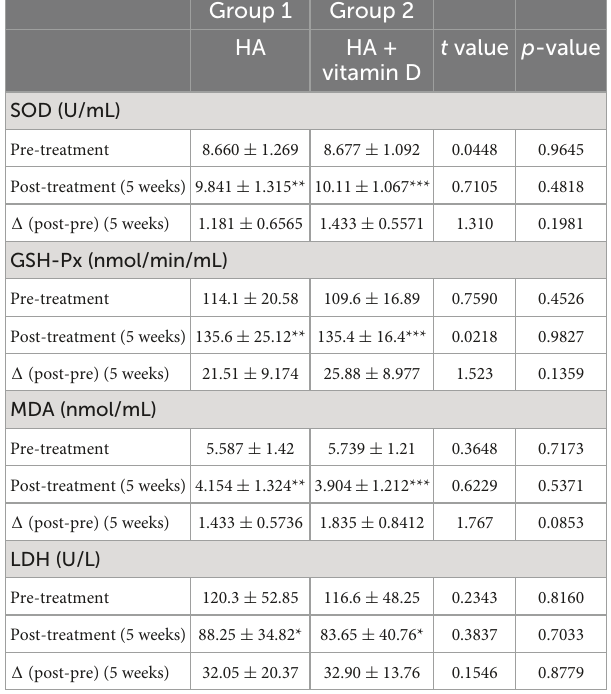
TABLE 3 OS levels in synovial fluid between patients with stage II-III OA and stage IV OA. OA (II-III)